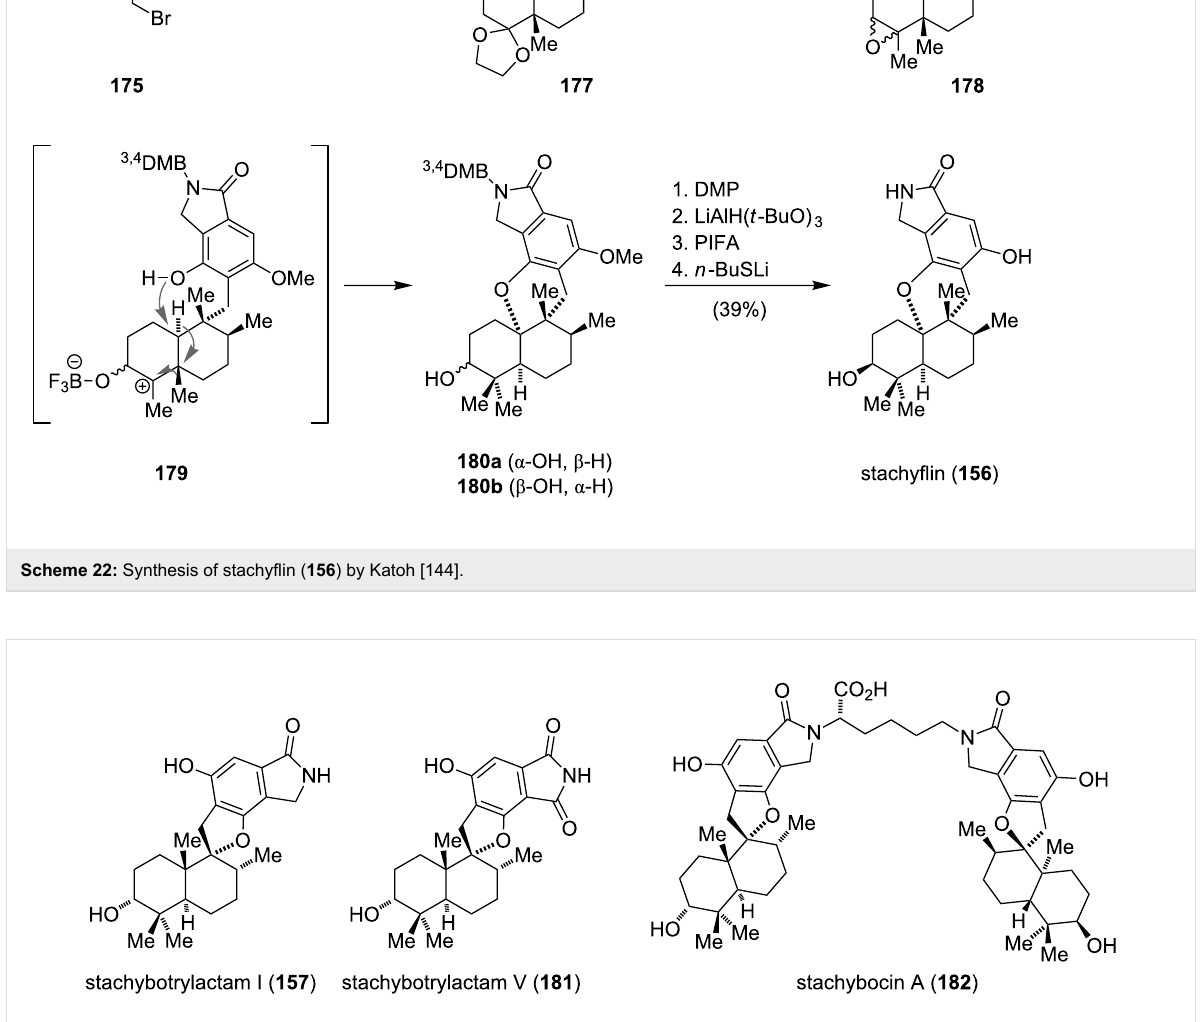
Figure 9: Selected examples of